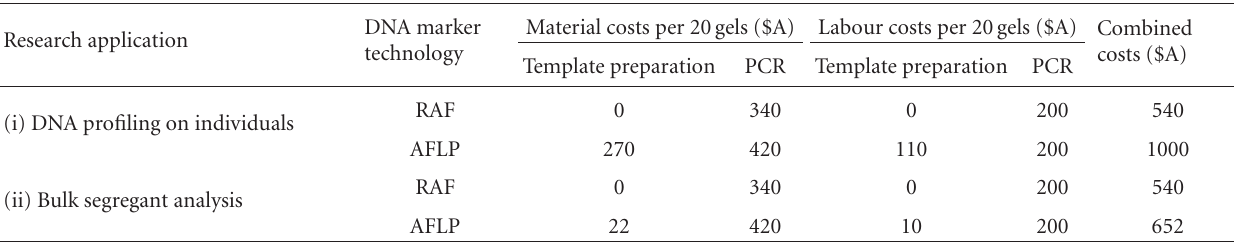
Table 1. Comparative costs of template preparation and PCR in RAF and AFLP. The two research applications given are the equivalent of (i) profiling 2,000 DNA markers on 48 individual DNA samples, and (ii) using bulk segregant analysis to map 20,000 DNA markers for linkage to a gene of interest (four DNA samples; two parents and two bulks). Estimated costs are in Australian dollars ($A). Labour costs were estimated at $20 per hour. Electrophoresis and detection costs are the same for both protocols, and these costs were not